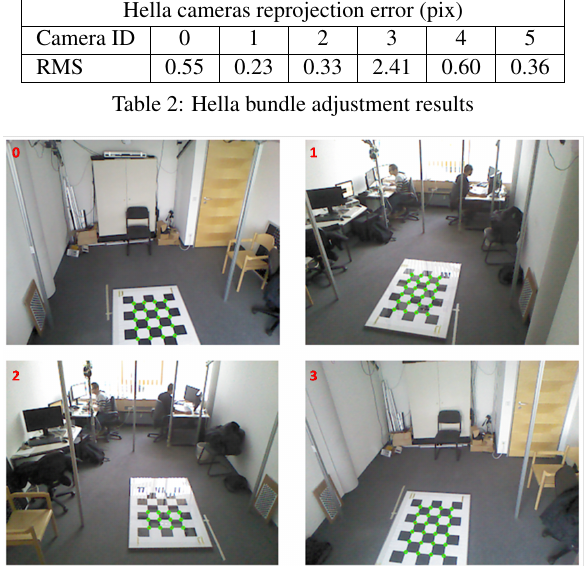
Figure 6: Corrected chessboard points after applying bundle ad- justment to all four Kinect sensors